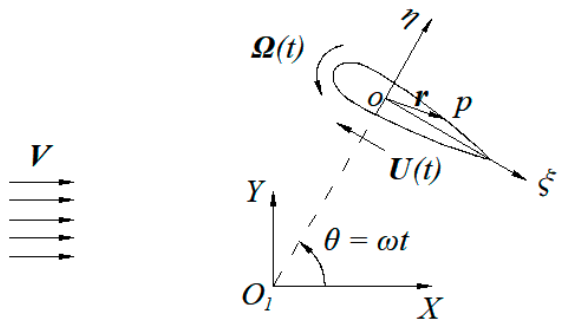
Figure 2. Schematic diagram of blade motion and the local coordinate system.